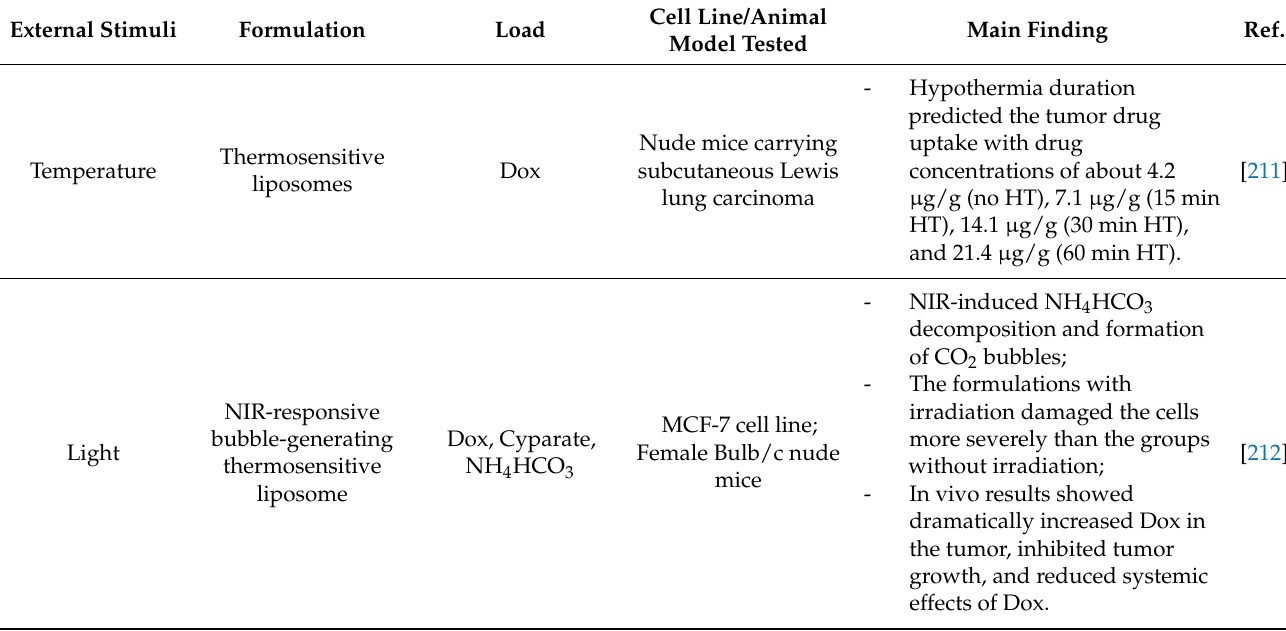
Table 4. Recent studies focusing on external stimuli triggered